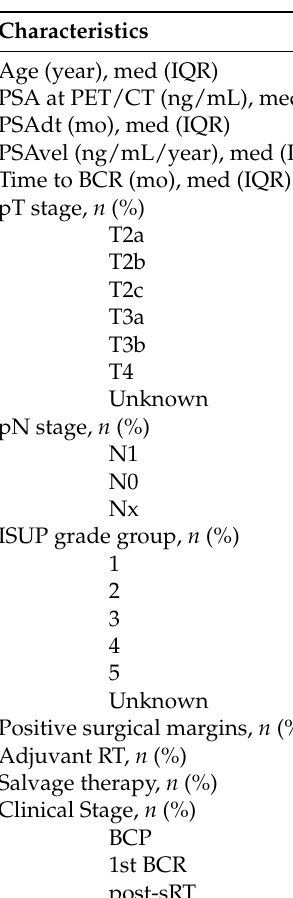
Table 1. Clinical characteristics ( n =